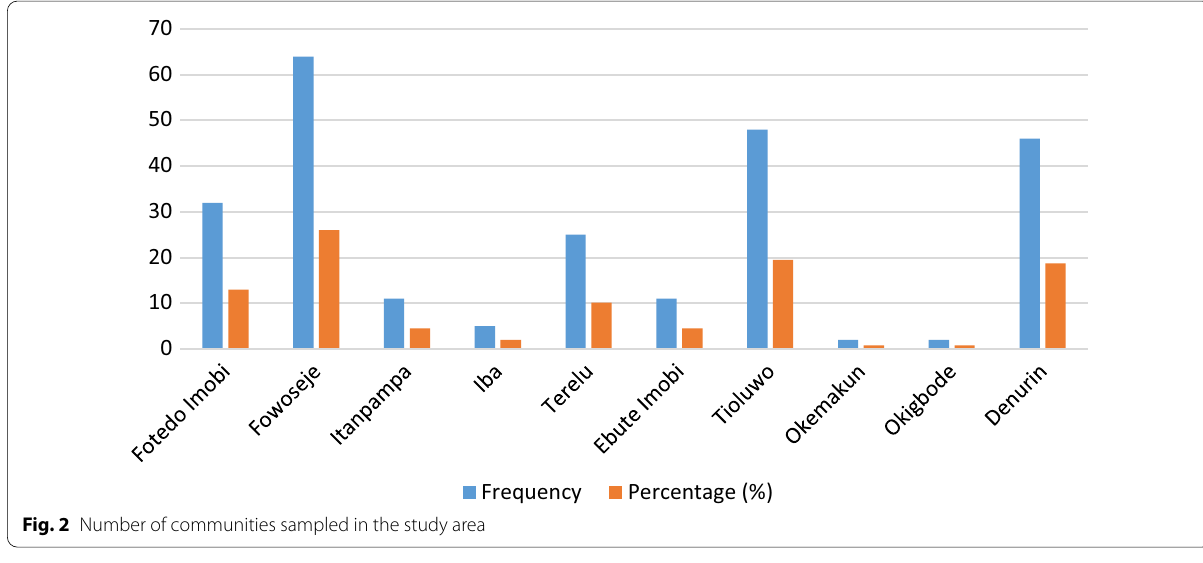
Fig. 2 Number of communities sampled in the study area